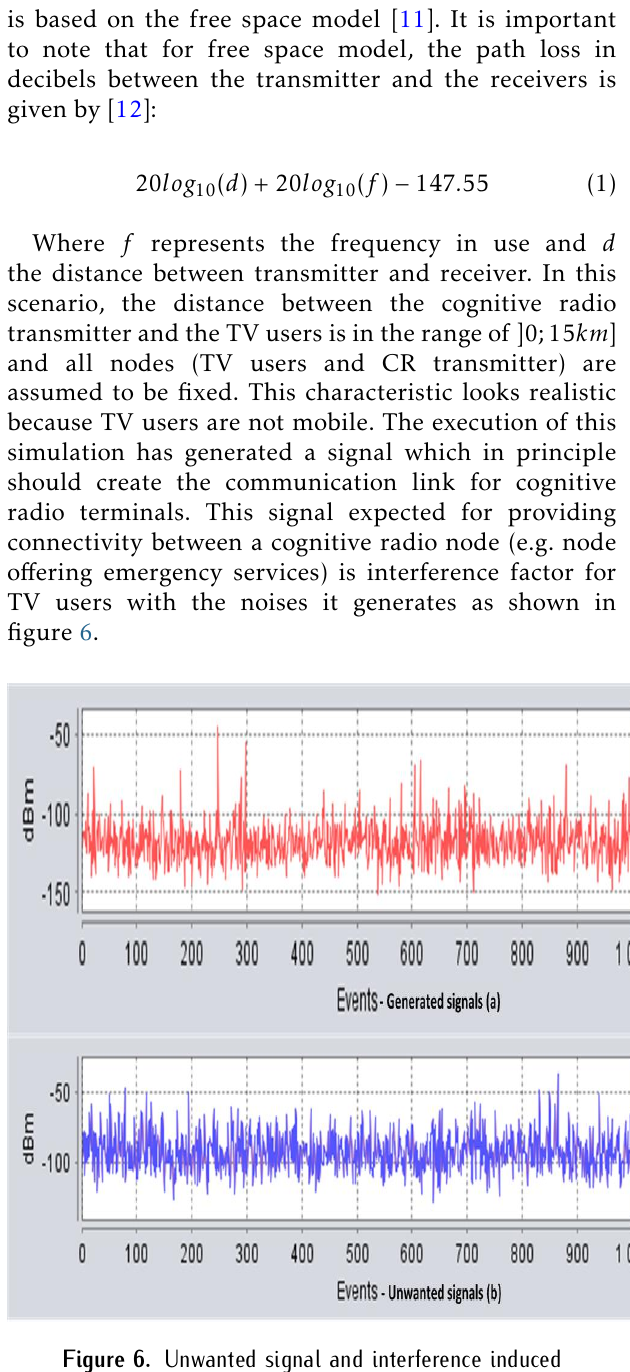
Figure 6. Unwanted signal and interference